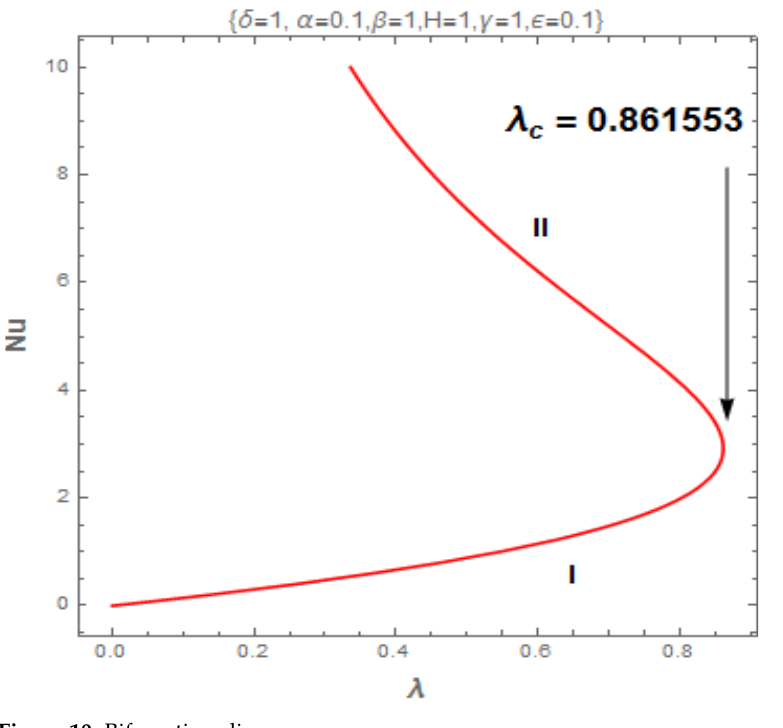
Figure 10. Bifurcation slice.